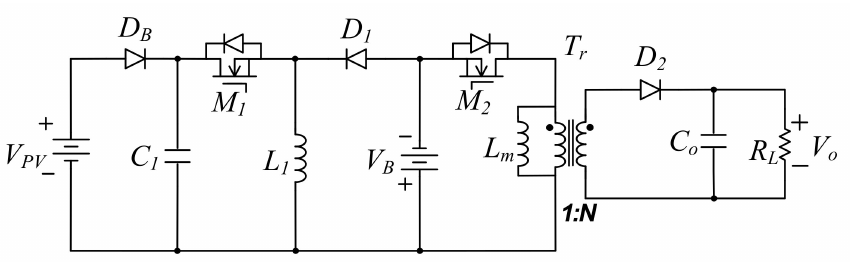
Figure 3. Schematic diagram of buck-boost/flyback hybrid converter for battery charging and discharging